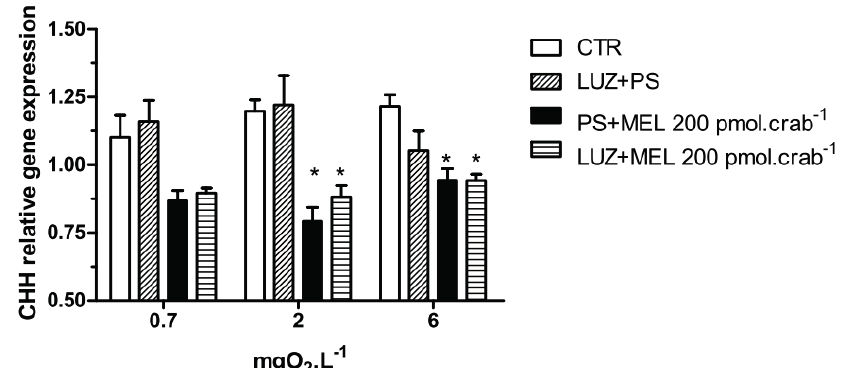
Figure 7. Crustacean Hyperglycemic Hormone (CHH) relative gene expression in the eyestalks of Neohelice granulata exposed for 45 min to three different dissolved oxygen concentrations (0.7, 2 or 6 mgO 2 ·L − 1 ) and injected with physiological saline only (CTR), luzindole (200 nmol·crab − 1 ) plus physiological saline, physiological saline plus melatonin (200 pmol·crab − 1 ), or luzindole (200 nmol·crab − 1 ) plus melatonin (200 pmol·crab − 1 ). Each point represents the mean ± SE ( n = 3–4). * represents a significant difference ( p < 0.05) from the CTR. The values are normalized for β -actin gene expression.